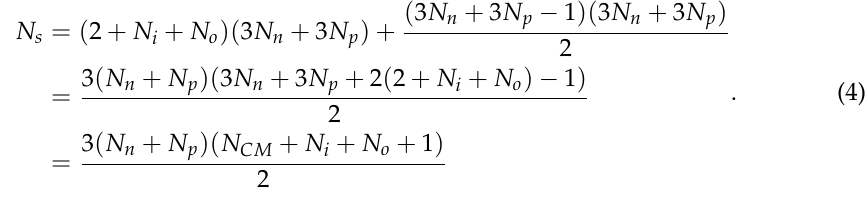
Figure 4. State definition. Because a symmetric CM does not allow self-connection, as well as connec- tions between VDD , GND , inputs, and outputs, the marked area contains the whole information for CM . They are flattened into a state vector ( s t